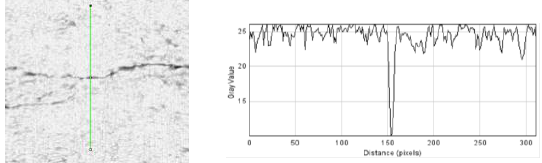
Figure 7. Post-processing of Rolling Ball Background